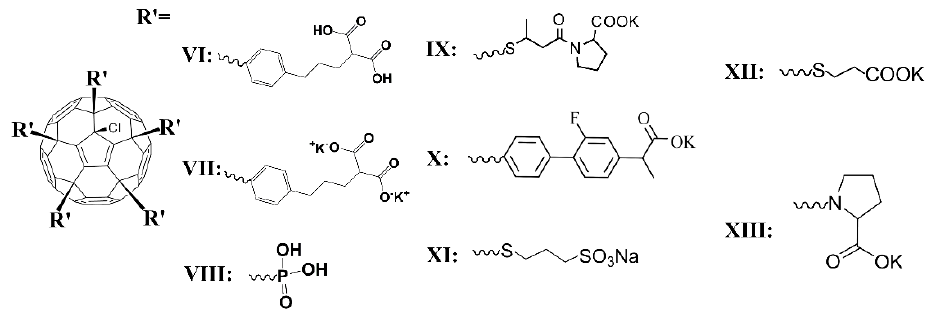
Figure 2. The molecular structure of compounds VI – XIII .